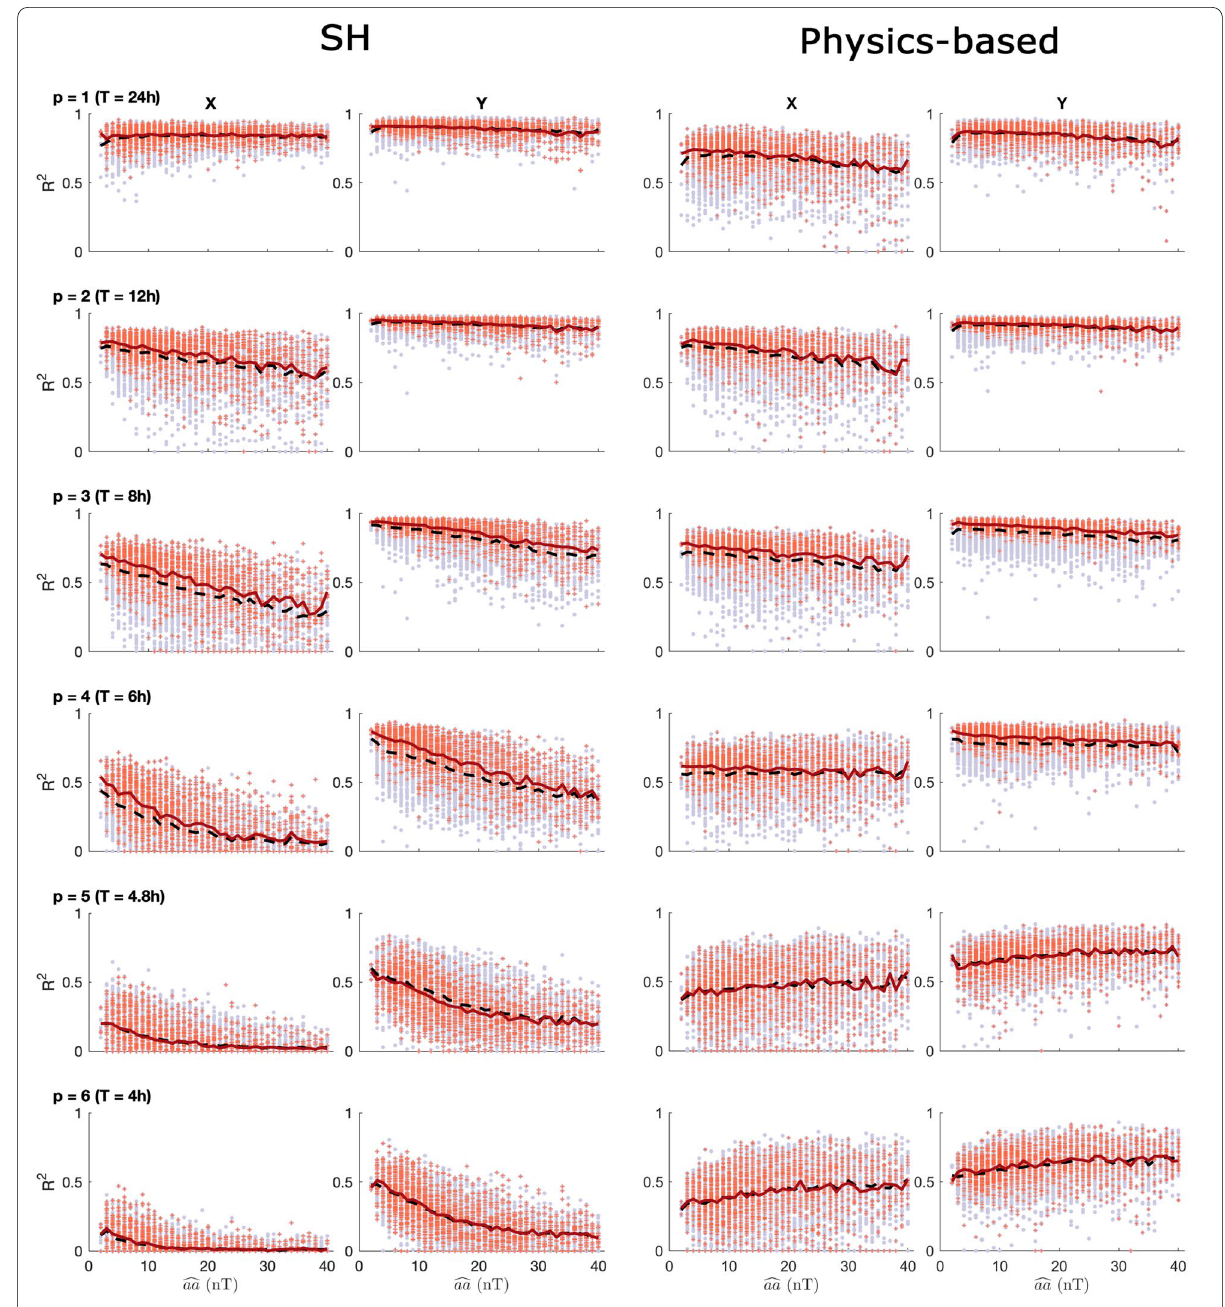
Fig. 9 Coefficient of determination R 2 for periods P 24, 12, 8, 6, 4.8, and 4 h for magnetic field components X and Y. X = − B θ and Y = B φ denote = the north and east components, respectively. Stations for estimating the Sq coefficients are limited to mid-latitudes between ± 5 ◦ and 55 ◦ . Two leftmost columns: R 2 computed by Guzavina et al. (2019) using a spherical harmonic parameterization of the source. Two rightmost columns: R 2 computed using a PCA-based parameterization of the source. The number of modes corresponds to the 99% threshold for the variance of the TIE-GCM stream function. PCA was applied to the whole 338 days TIE-GCM time series. FT segment length was taken as 24 h. Grey circles mark all days, and red pluses mark equinoctial days. The lines mark their mean values, respectively. The aa index indicates the level of geomagnetic disturbance, where a larger index stands for a more disturbed day; more details about this index can be found in Guzavina et al.